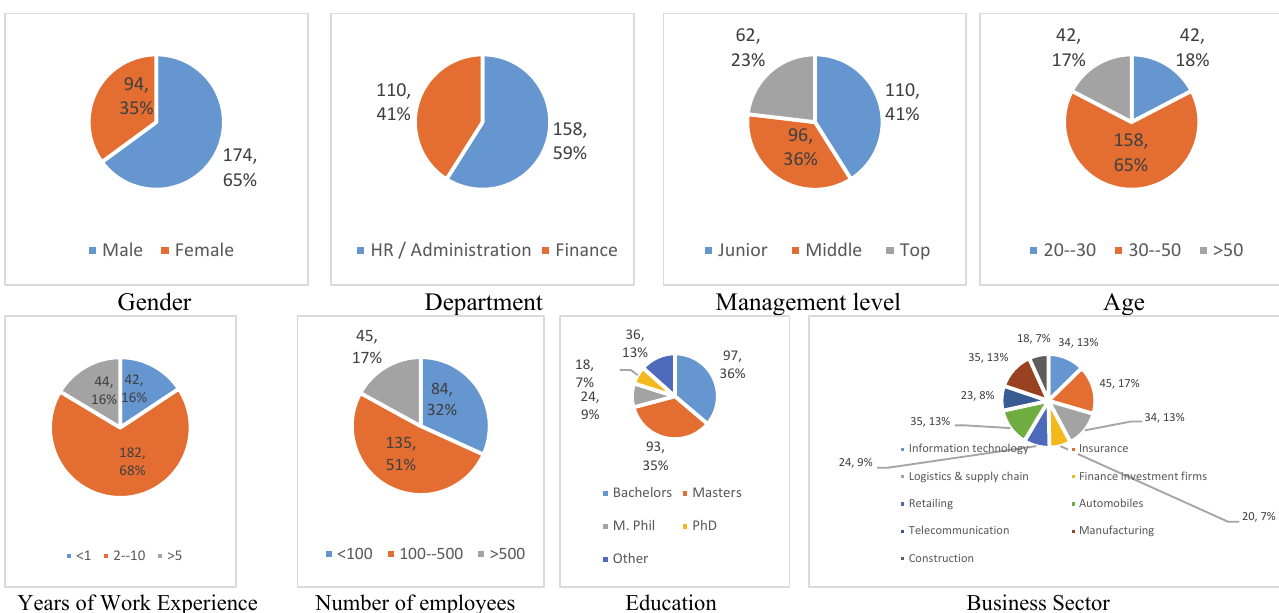
Fig. 1. Demographic Profile of the Respondents (n =